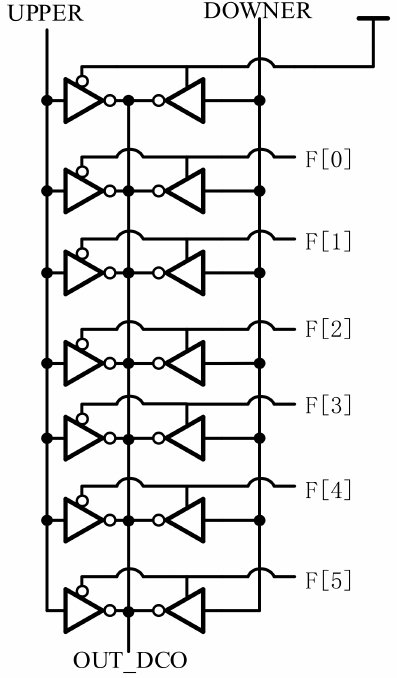
Figure 8. Schematic of the fine-tuning module.